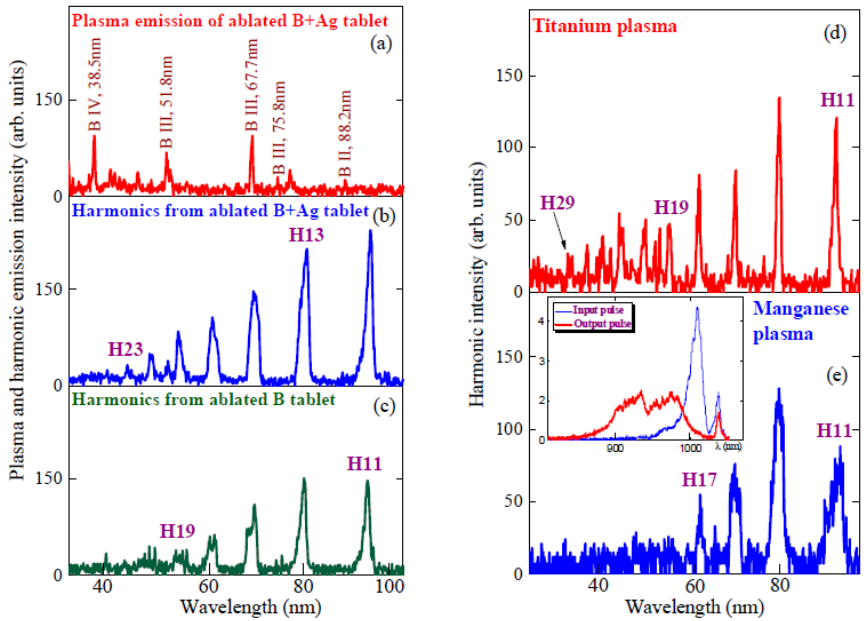
Figure 3. ( a ) Plasma emission from the ablated B + Ag tablet at strong intensity of 250 fs heating pulses ( I hp = 4.4 × 10 12 W cm −2 ), ( b ) harmonic emission from the ablated B + Ag tablet at optimal intensity of heating pulses ( I hp = 1.5 × 10 12 W cm −2 ), ( c ) harmonic emission from the ablated bulk B at similar conditions, ( d ) harmonics generated from titanium LPP, ( e ) harmonics generated from manganese LPP.